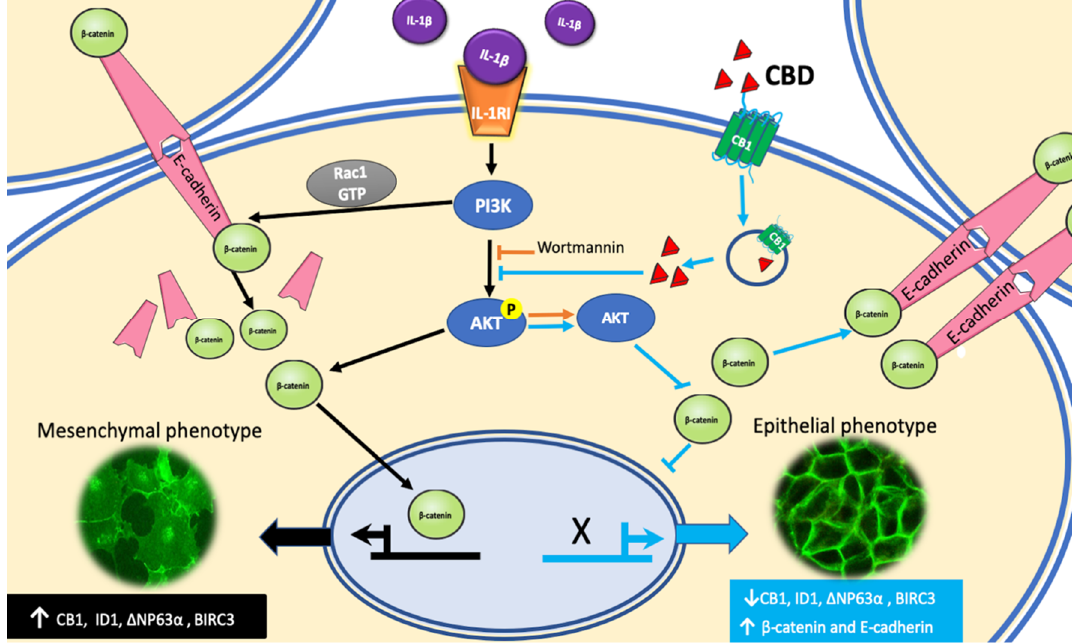
Figure 8. CBD blocks the IL-1β/IL-1RI/β-catenin pathway and induces an epithelial phenotype. A hypothetical model of CBD blockage of the IL-1β-activated signaling pathway that leads into a malignant phenotype is represented by the black pathway. CBD binding to its receptor CB1 induces AKT activation and blocks the translocation of β-catenin into the nucleus. CBD also decreases the expression of malignant markers such as ∆NP63α isoform, BIRC3, and ID1 ( blue pathway ). CBD increased epithelial marker E-cadherin and its associated β-catenin in the adherens junction resulting in cells with an epithelial phenotype.